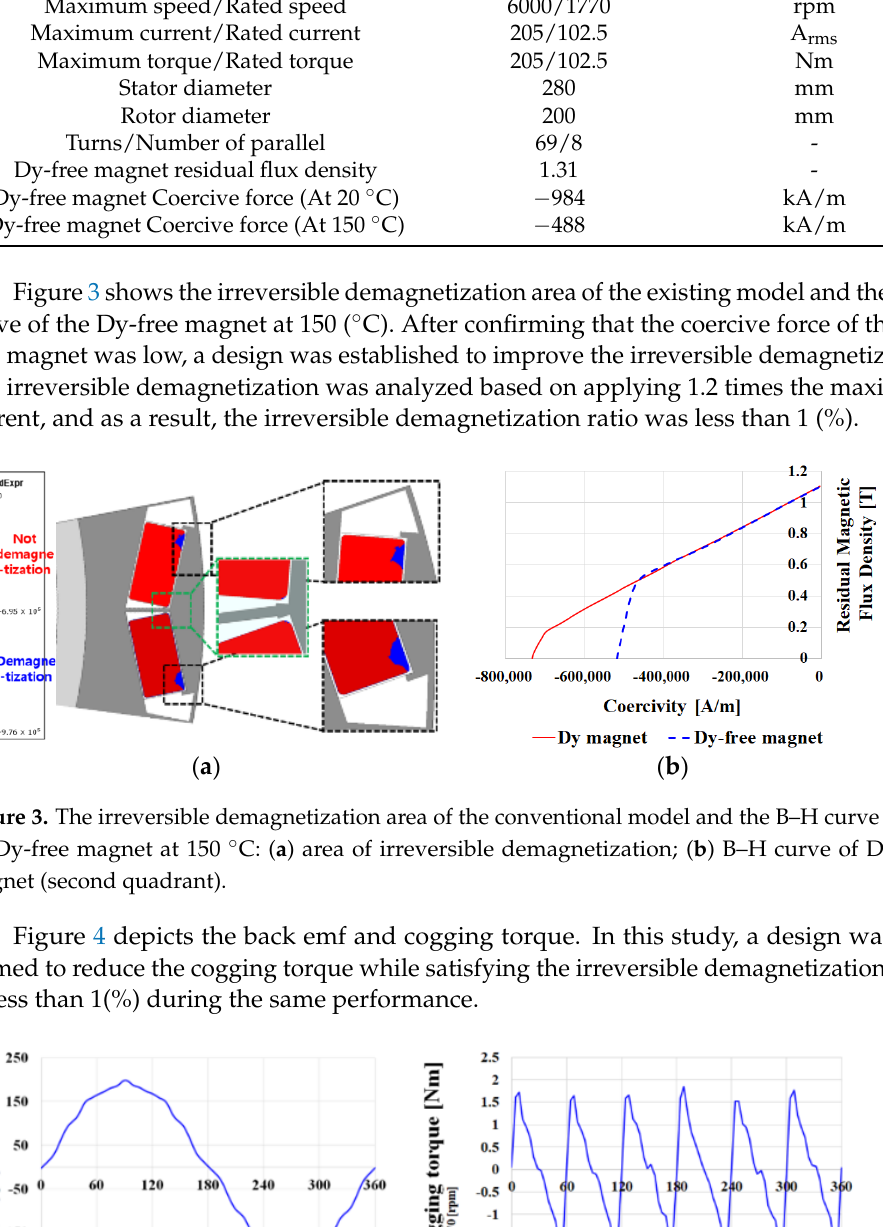
Table 1. Specification of 35kW class hybrid traction motor with Dy-free magnet.